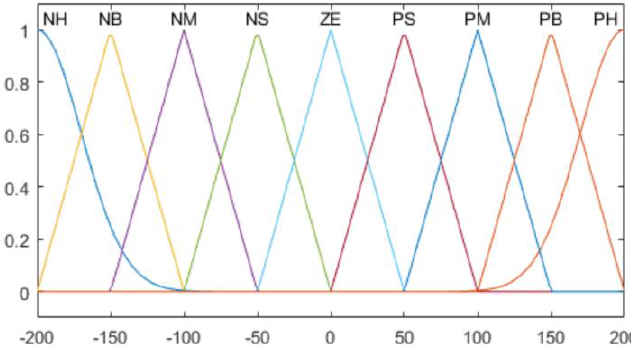
Figure 15. Contact pressure error membership functions (MFs).